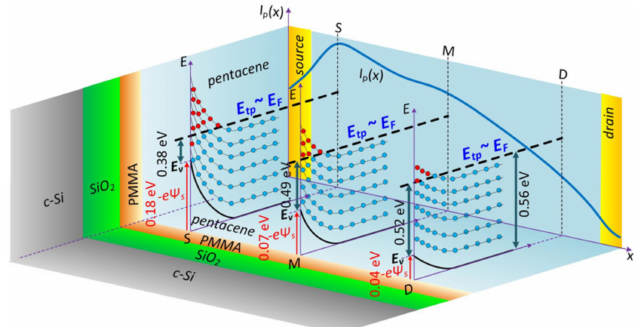
Figure 2. Schematic representation of the upward band bending at pentacene insulator interface for different positions in the transistor channel. The magnitude of the band bending − e Ψ s (red arrows) from the negative V GS voltage is deduced from the listed energy gaps ( E tp − E v ) obtained from the SR-SPCM spectra by placing the laser beam near the source (S), midway between the source and drain (M), and near the drain (D). Note that only the relative positions of E tp and E v levels can be determined. Their variation along the channel due to the applied V DS = − 10 V cannot be deduced from our measurements. However, this voltage produces a reduction in − e Ψ s from source to drain, which is captured by the increase in the energy gap ( E tp − E v ). Due to the band bending, empty hole traps (blue circles) are lifted above the E tp level and become filled with trapped holes (red circles) in the accumulation layer at the insulator interface, The I p ( x ) profile (solid blue line) obtained for V GS = − 20 V and V DS = − 10 V reflects the inhomogeneous profile of trapped holes (red solid circles).